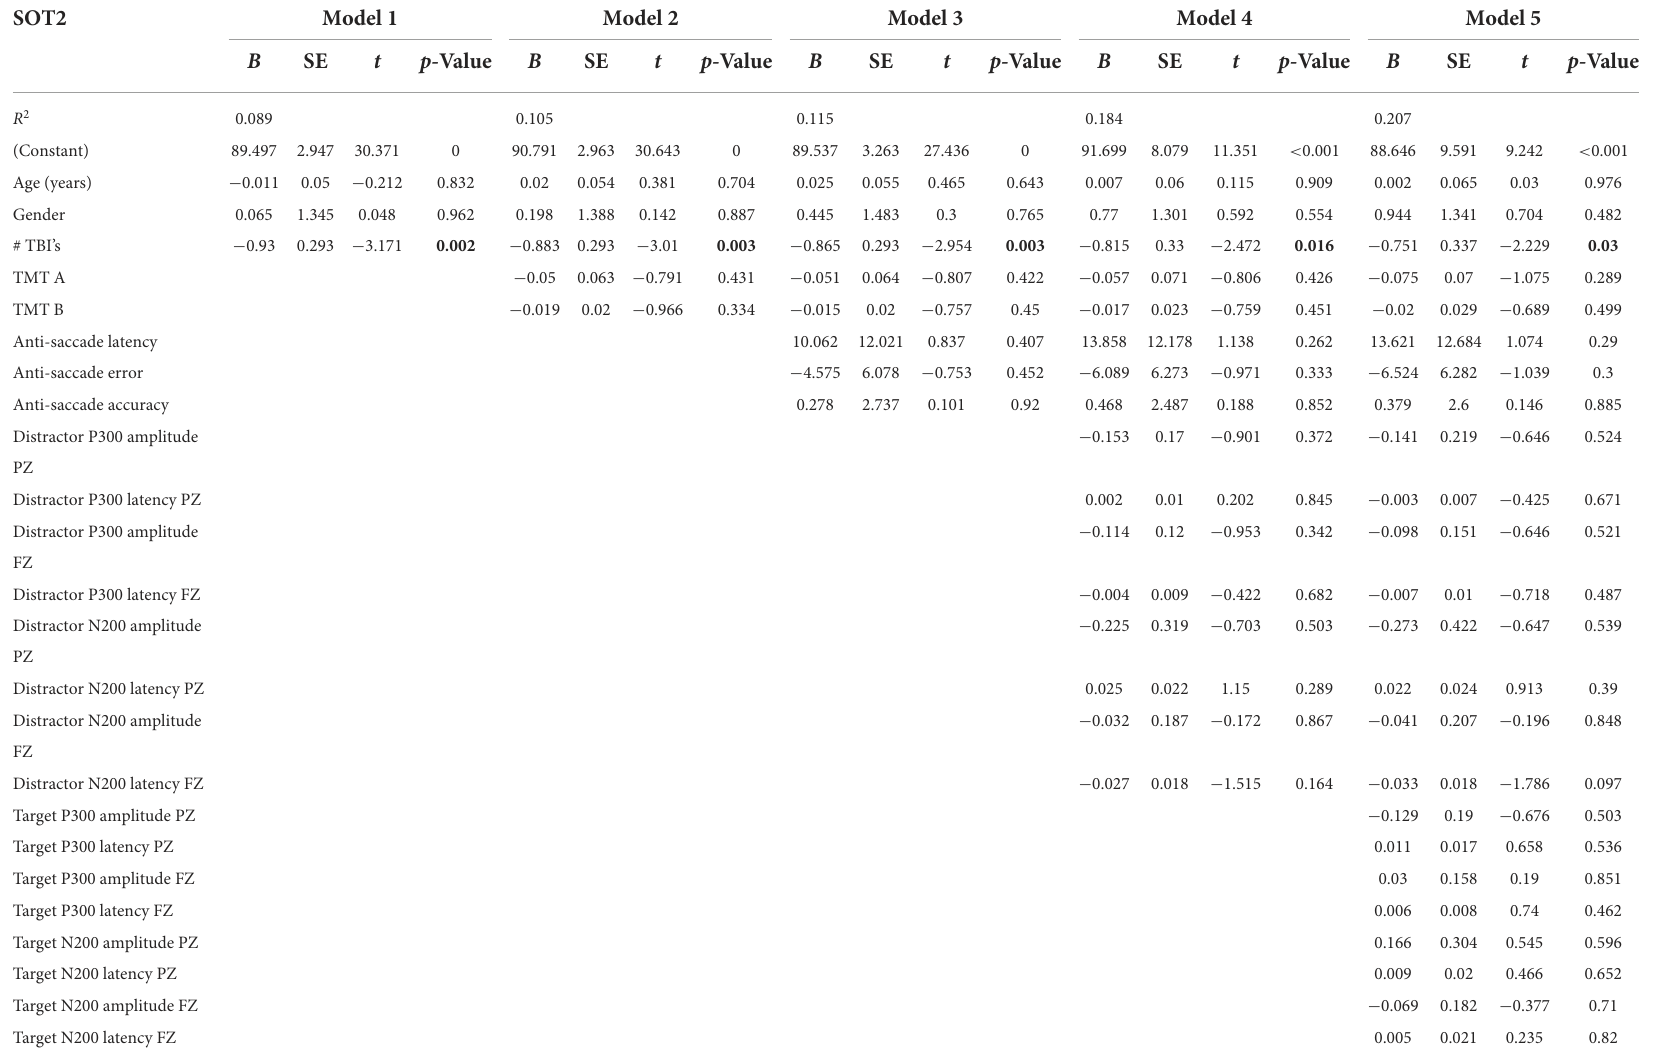
TABLE 4 Results from the hierarchical regression for SOT2, occluded